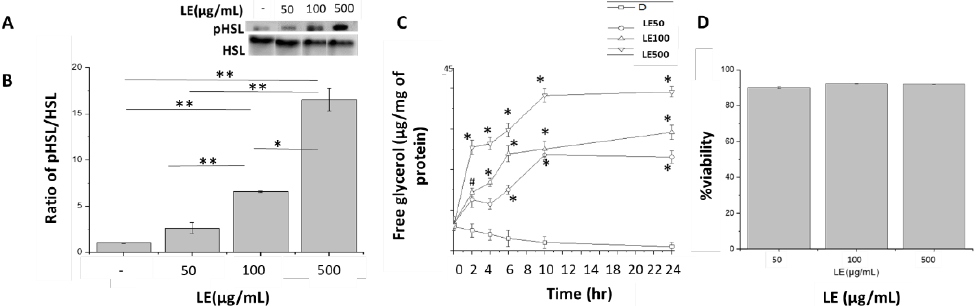
Figure 3. Stimulation of lipolysis by lemon extract (LE). ( A ) Blot for protein expression for pHSL and HSL in untreated differentiated cells, differentiated cells treated with LE dose of 50, 100 and 500 µg/mL. ( B ) Quantified protein expression for pHSL and HSL in untreated differentiated cells and differentiated cells treated with LE, at a dose of 50, 100 and 500 µg/mL. ( C ) Free glycerol release from treated and untreated cells after t = 0, 2, 4, 6, 10 and 24 h. * significant at p = 0.01 and # significant at p = 0.05. ( D ) Differentiated cells alone, differentiated cells treated with LE, at a dose of 50 µg/mL (LE50), differentiated cells treated with LE, at a dose of 100 µg/mL (LE100) and differentiated cells treated with LE, at a dose of 500 µg/mL (LE500) ( D ) Cell viability in the presence of LE, at a dose of 50, 100 and 500 µg/mL. ** significant at p = 0.01 and * significant at p = 0.05. For ( C )